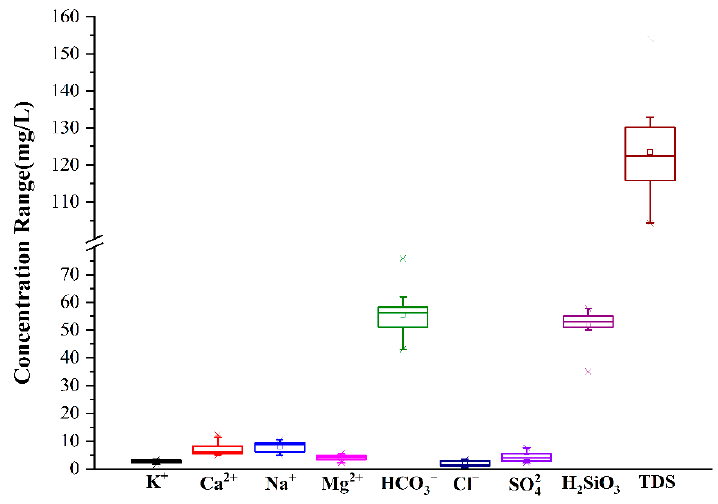
Figure 3. Box diagram of main components.